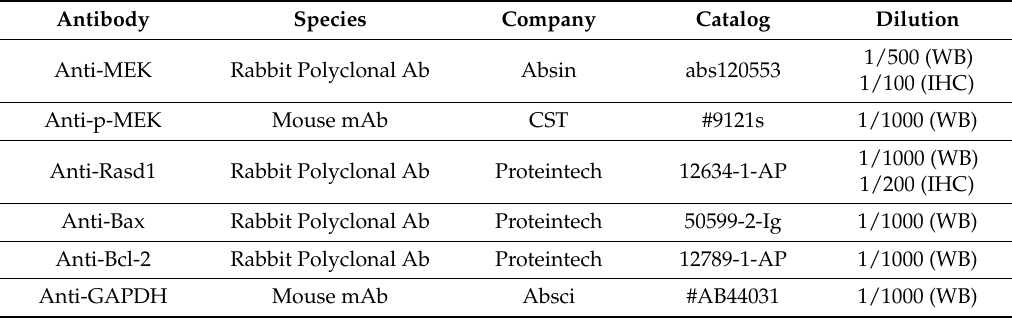
Table 1. Antibodies used for Western blot (WB) and Immunohistochemistry (IHC) analysis. Antibody Species Company